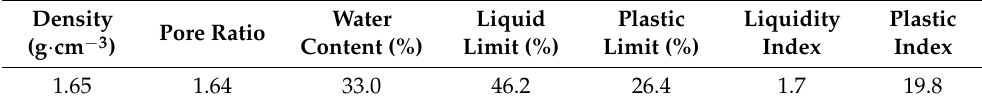
Table 1. Physical property indexes of subgrade soil [25].